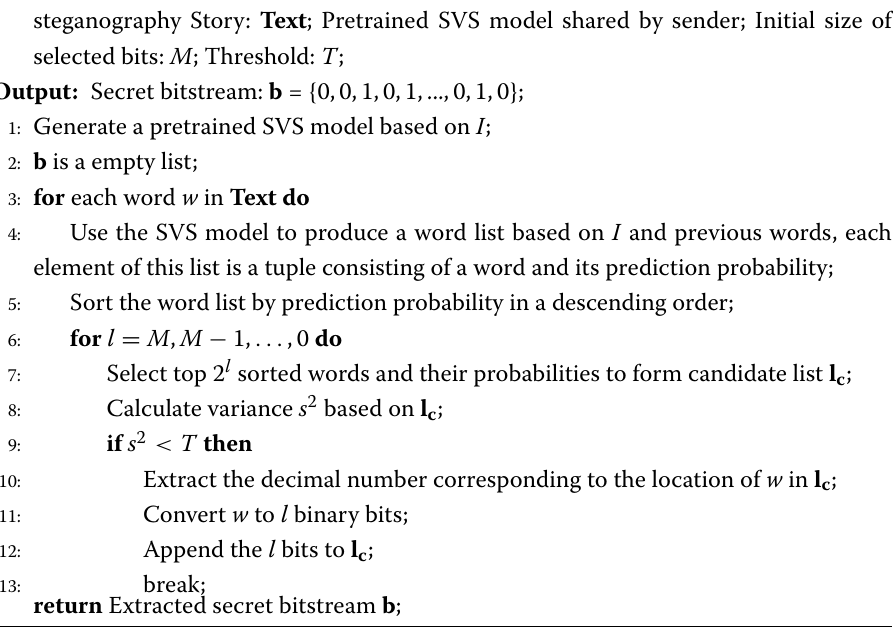
Algorithm 2 Adaptive Information Extracting